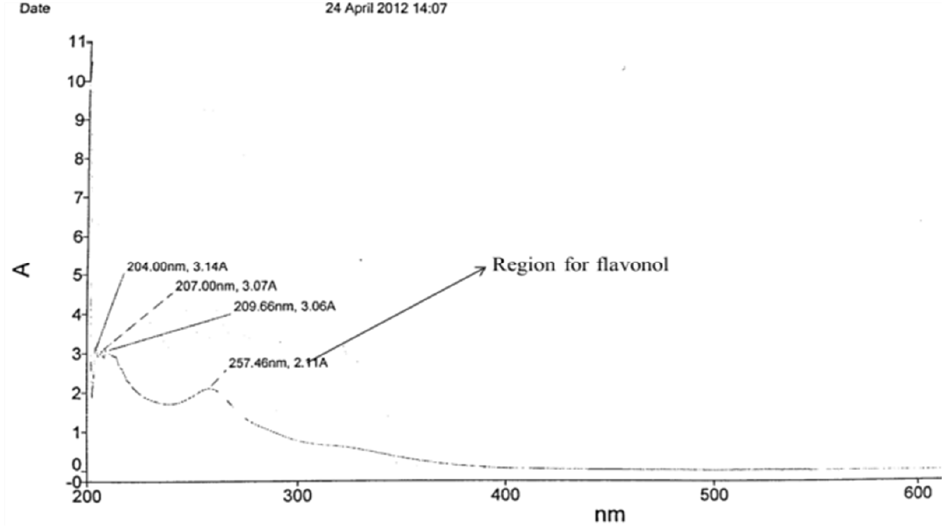
Figure 11. UV spectrum for the crude of methanolic extracted from gorse leaves.